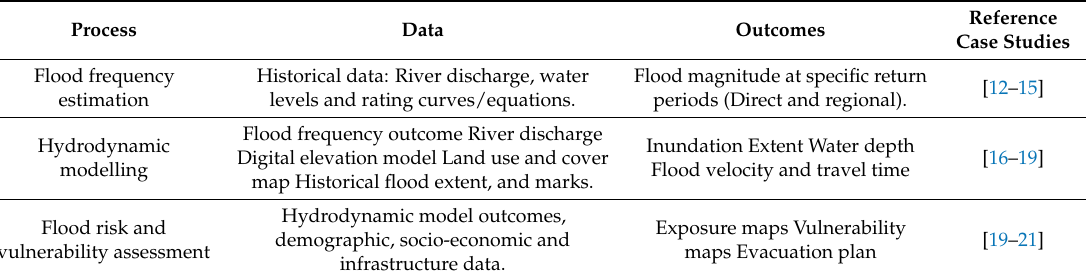
Table 1. Flood mapping process and fundamental data requirements, outcomes and case studies. Process Data Historical data: River discharge, water levels and rating